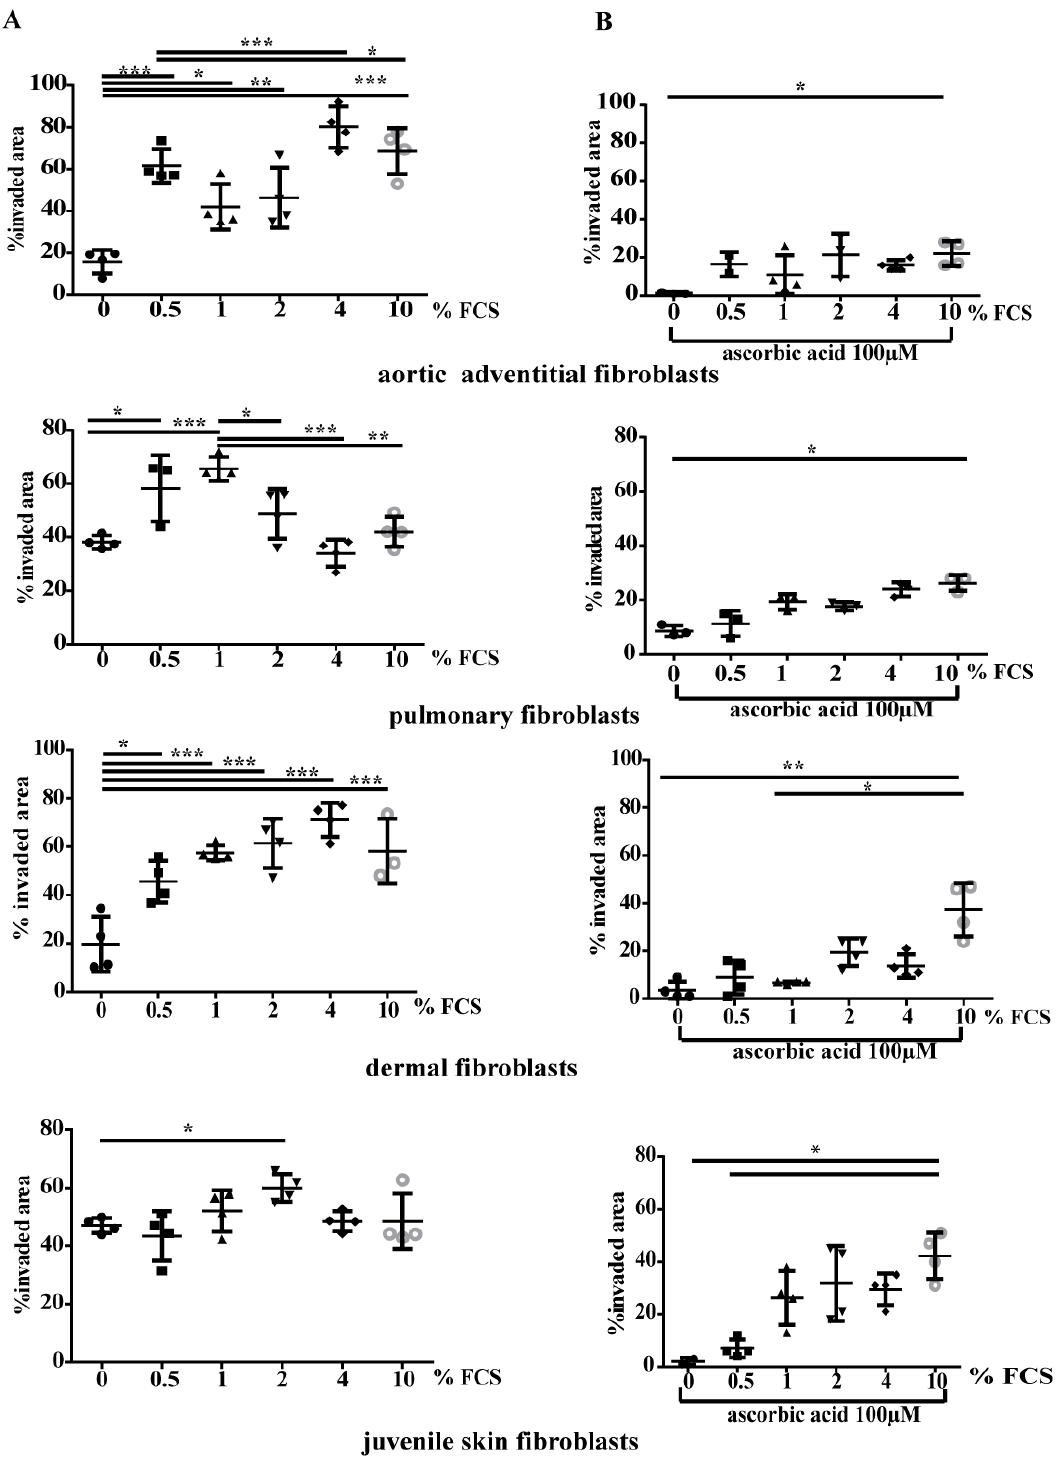
Figure 5. Migration of fibroblasts is reduced by addition of AA to FCS. ( A ) Migration of different fibroblast types incubated with different concentrations of FCS is demonstrated as % invaded area in scatter blots. In ( B ) migration with additional AA to different FCS concentrations is shown. * p < 0.05, ** p < 0.01, *** p < 0.001.